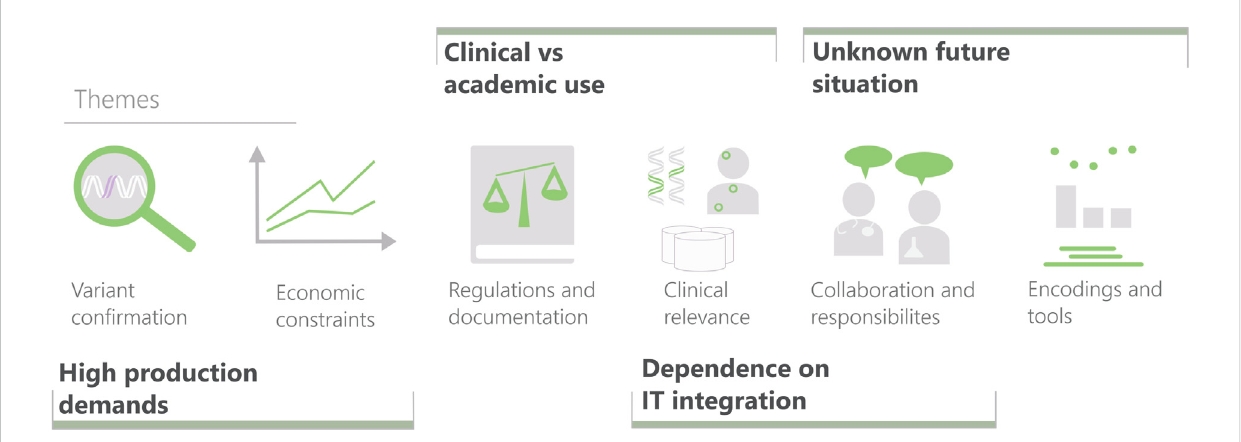
FIGURE 2 The six themes characterizing variant interpretation created from interview data and the four elicited challenge areas for visualization research in clinical settings (bold), including their relation to the themes. Themes, from left to right: Variant con fi rmation (mainly ruling out false positives). Effects of limited time and resources. Constraints imposed by laws and regulations (ranging from IT security to validation of laboratory processes). Evaluating the clinical relevance ofa variant. The interplay between the professions involved in the diagnostic work. Encodings and tools used for displaying